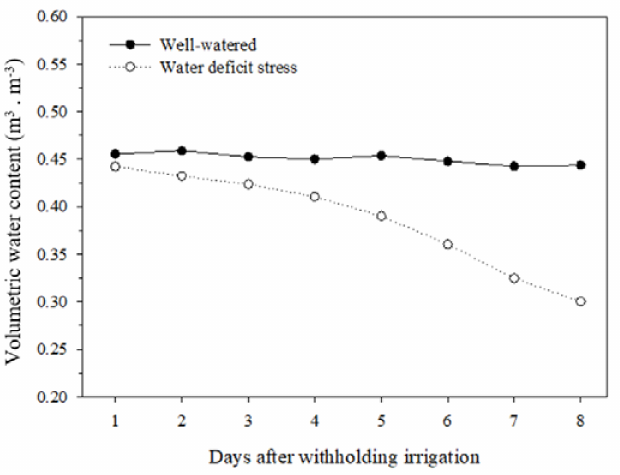
Figure 1. Volumetric water content in well-watered and water-deficit stress conditions for 8 days.